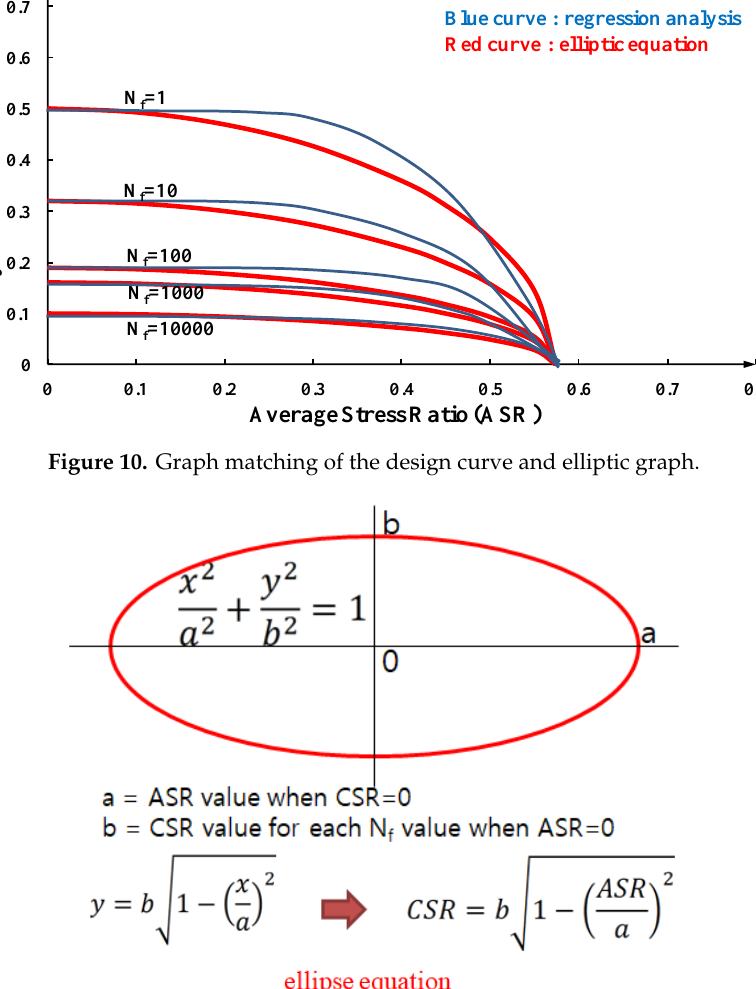
Figure 11. Elliptic graph and equation.